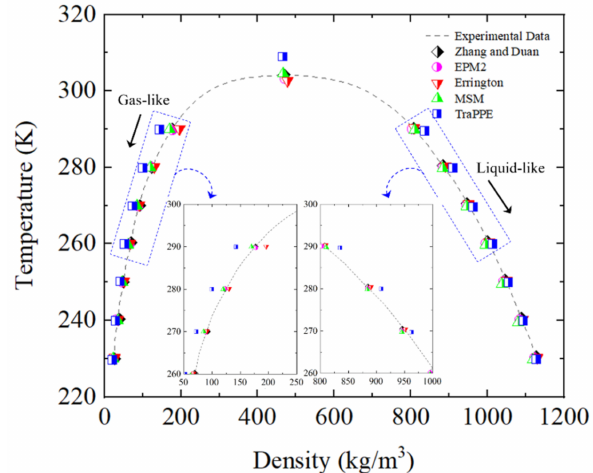
Figure 2. Coexistence envelopes of Zhang and Duan, EPM2, Errington, MSM, and TraPPE models and their comparisons with experimental data.(For an in-depth interpretation of these data, readers are referred to Zhang and Duan paper